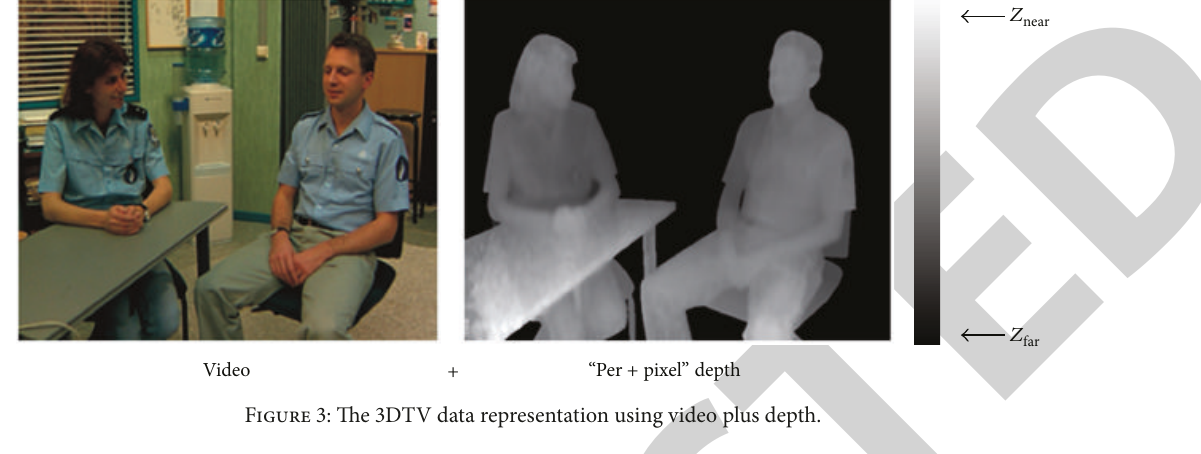
Figure 3: The 3DTV data representation using video plus depth.